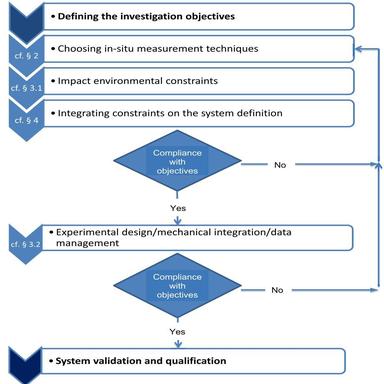
Simplified flow diagram illustrating the minimum arrangements for the deployment of appropriate in-situ measurement techniques for each constrained environment.